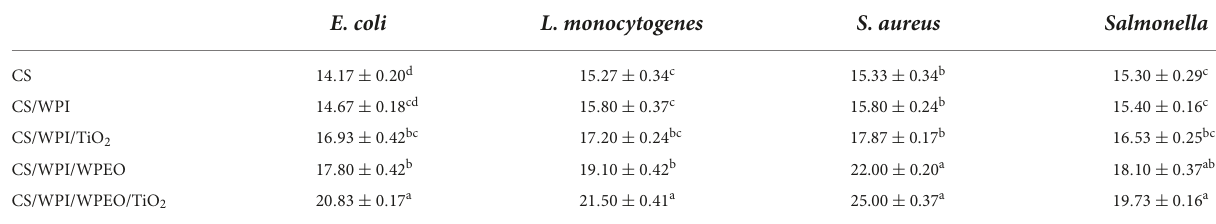
TABLE 4 The inhibitory zone diameter of the composite films.